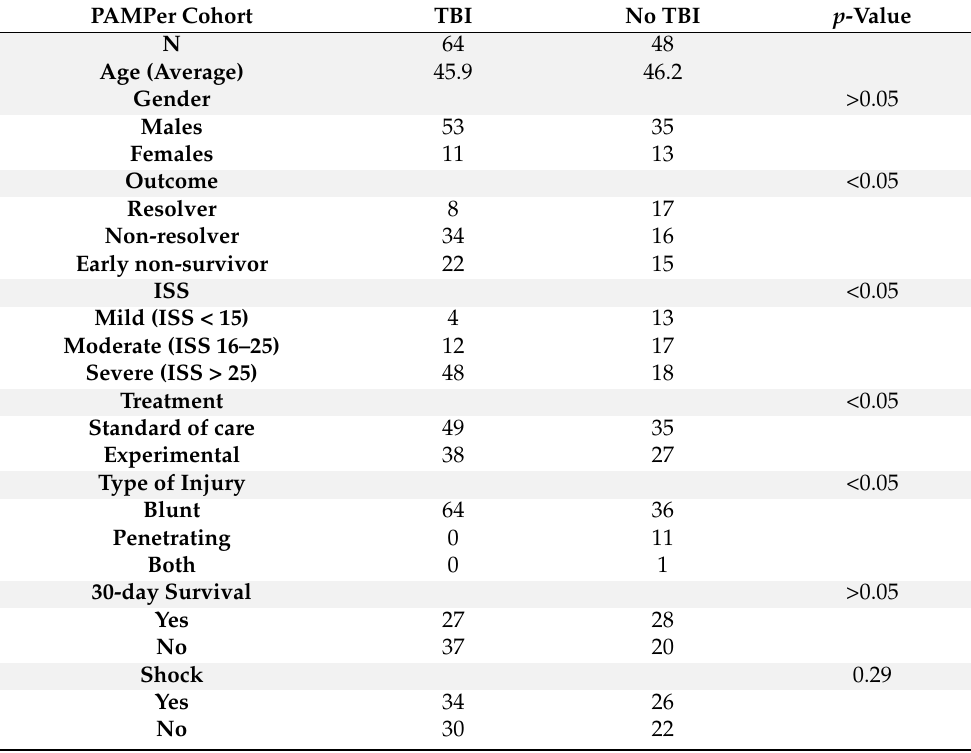
Table 1. Demographic characteristics of patients used to train the LASSO models based on presence of traumatic brain injury (TBI). PAMPer Cohort TBI No TBI p -Value